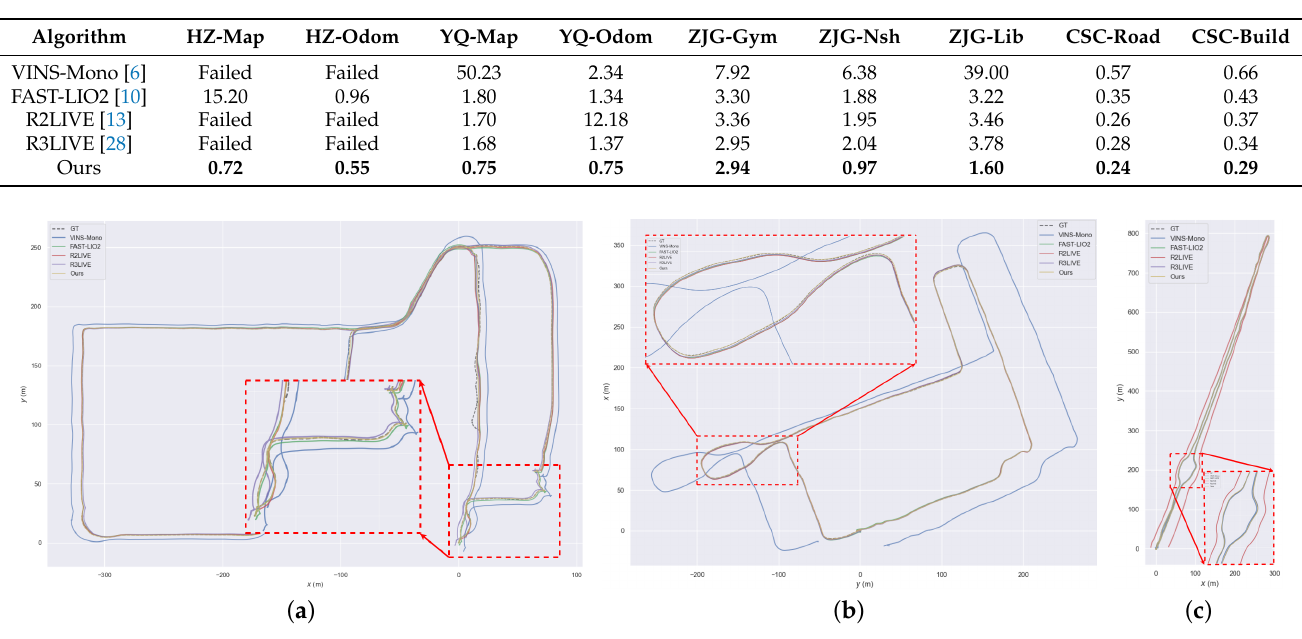
Figure 12. ( a ) The image view of our HZ-map dataset. ( b ) The trajectory of GNSS, FAST-LIO2 and our system. VINS-Mono failed due to the aggressive motion. ( c ) The map built by our system aligned with Google Earth. As a result of the GNSS fusion in our system, we obtain a highly accurate result. Table 2. RMSE translation error w.r.t GPS.